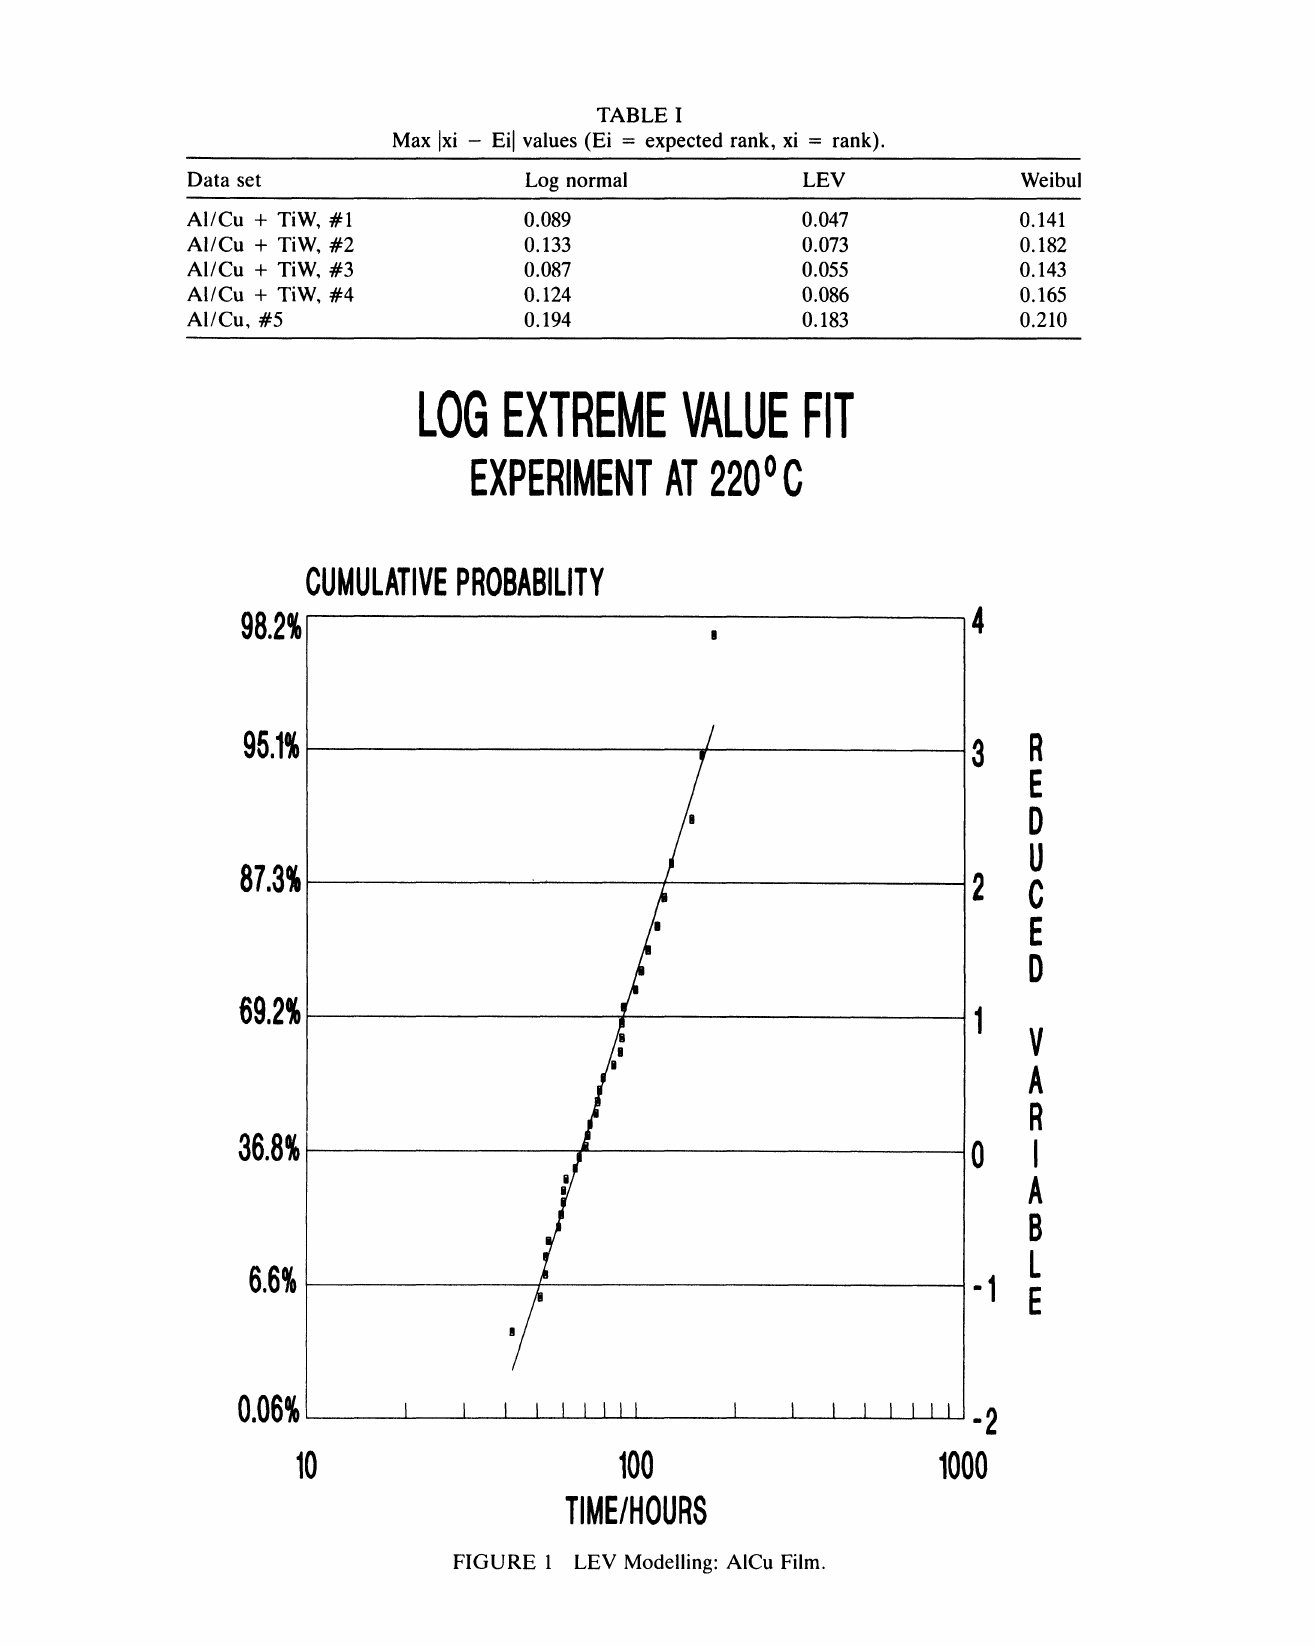
FIGURE LEV Modelling" AICu